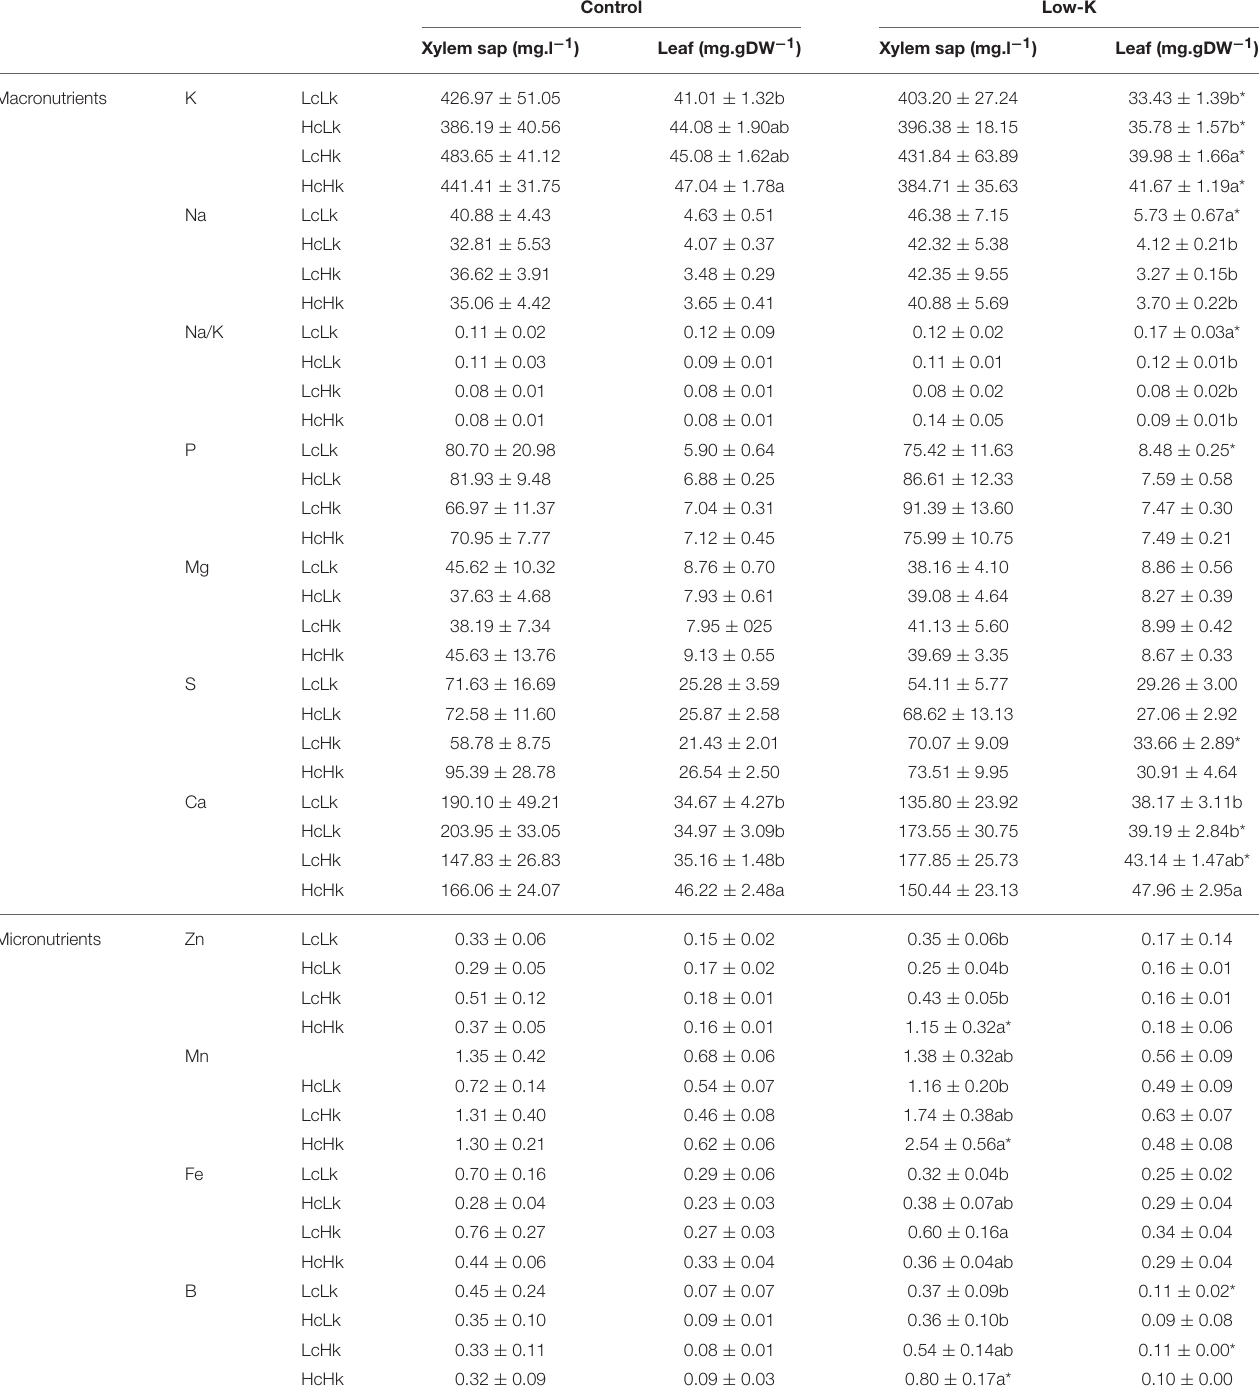
TABLE 1 | Potassium (K), sodium (Na), Na/K ratio, phosphorous, (P), iron (Fe), magnesium (Mg), sulphur (S), calcium (Ca), zinc (Zn), manganese (Mn), boron (B) in root xylem sap and leaf of the scion ( Solanum lycopersicum cv. Boludo F1) grafted onto a population of recombinant inbred lines (RILs)